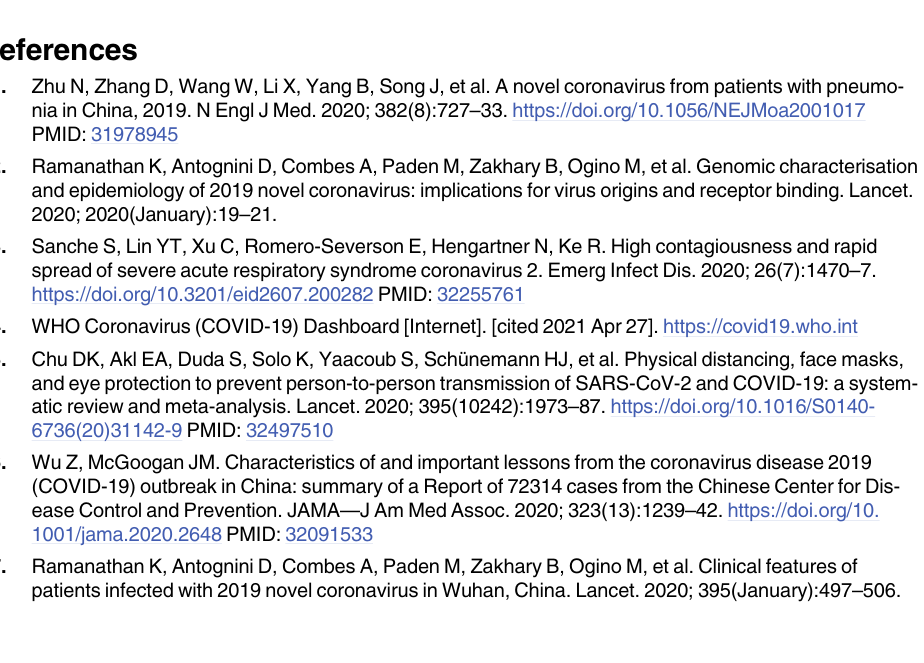
S1 Table. Demographic variables of the study population for COVID-19 severity. Data pre- sented as median (Q1-Q3) or number (percentage) of patients. � Data on 3 patients was miss- ing. AHI, apnea-hypopnea index; BMI, body mass index; COPD, Chronic obstructive pulmonary disease; COVID-19, Coronavirus disease 2019; CPAP, continuous positive airway pressure; CVD, cardiovascular disease; DM, diabetes mellitus; ICU, intensive care unit; LSAT, low oxyhemoglobin desaturation, ODI, oxygen desaturation index; OSA, obstructive sleep apnea; RDI, respiratory disturbance index; SD, standard